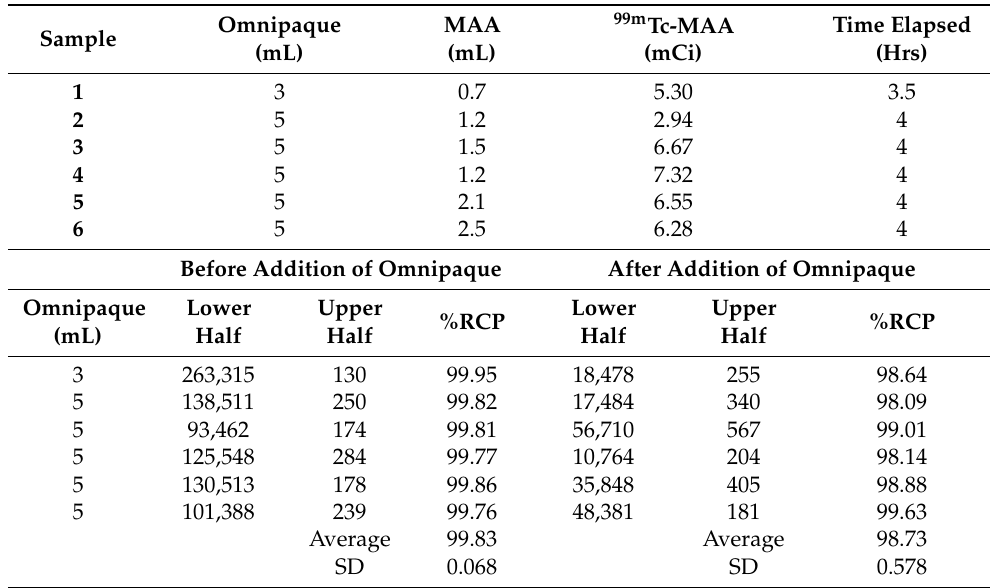
Table 1. ( a ) Volume of omnipaque, MAA, and 99m Tc radioactivity of six different samples. ( b ) Ra- diochemical purity as a percentage (%RCP) of the above samples before and after the addition of omnipaque.